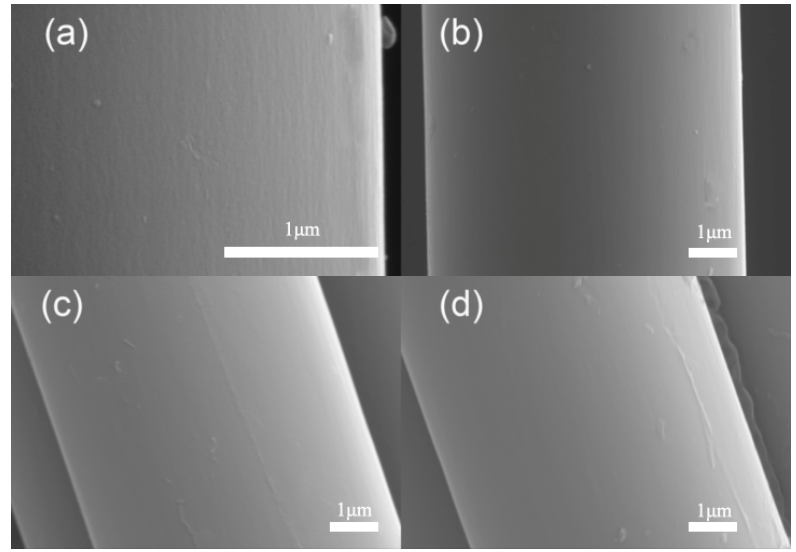
Figure 4. SEM images of CF surface treated with different EAO intensities. ( a ) 50 C/g, ( b ) 100 C/g, ( c ) 150 C/g, ( d ) 200 C/g. ( c ) 150 C/g, ( d ) 200